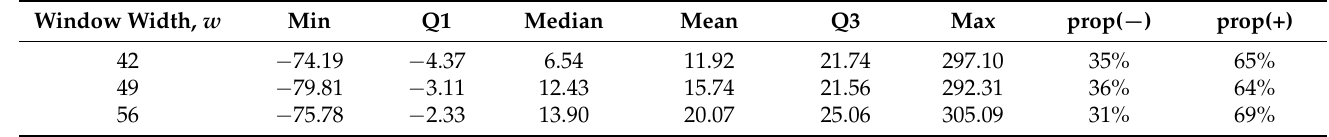
Table 2. Summary statistics of the w -day returns in the three window